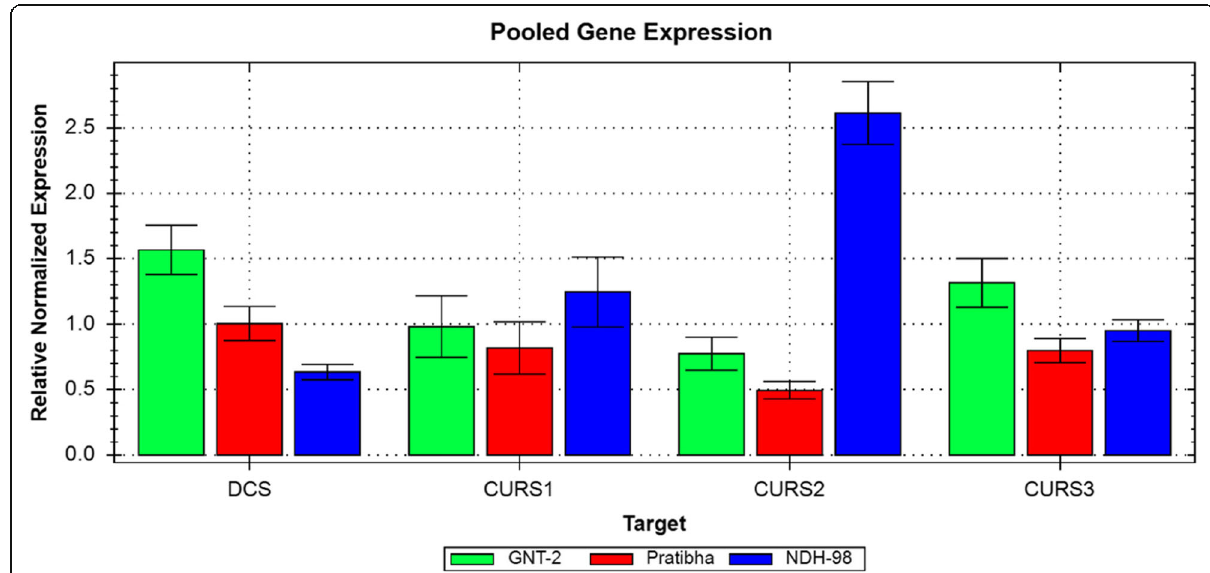
Fig. 2 Pooled gene expression in three turmeric cultivars. GNT-2, Pratibha, and NDH-98 are turmeric cultivars. DCS , diketide-CoA synthase. CURS1 , CURS2 , and CURS3 are multiple curcumin synthases. Pooled gene expressions are the averages of three stage (SI, SII, and SIII) expressions in each cultivar. DCS and CURS3 expressions are higher in GNT-2, a higher curcuminoid yielding cultivar, whereas CURS1 and CURS2 expressions are higher in NDH-98, a lower curcuminoid yielding cultivar